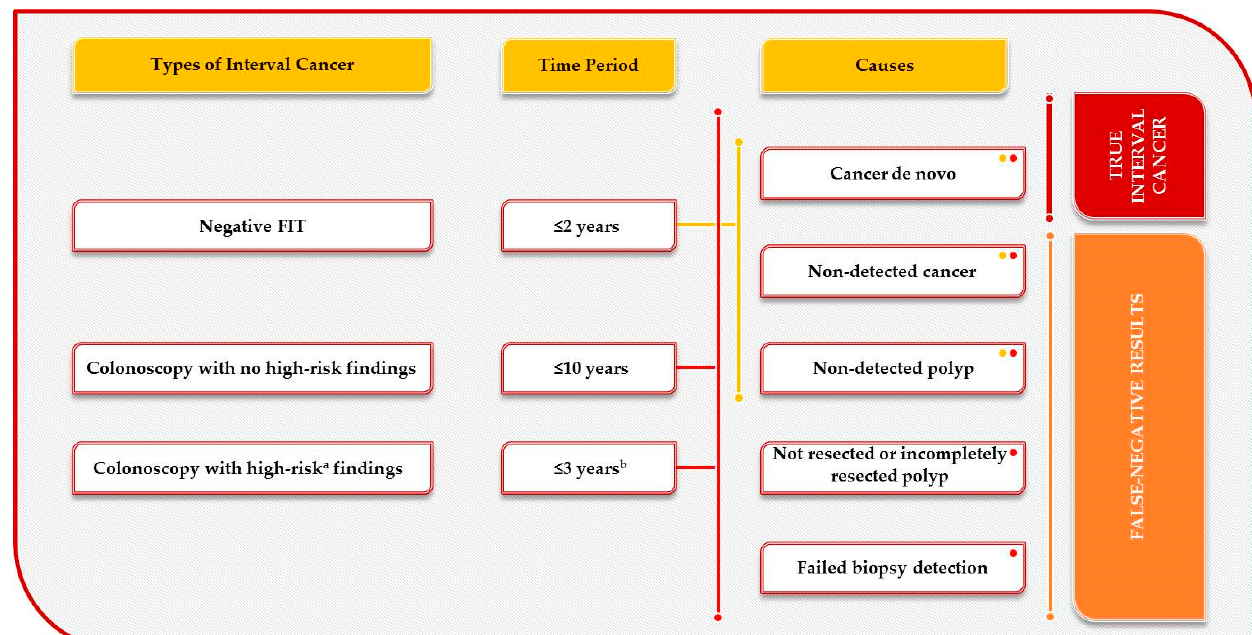
Figure 1. Causes of colorectal interval cancers. FIT interval cancer is caused by de novo cancer (true interval cancer) or non-detected lesions (false-negative FIT results). A post-colonoscopy colorectal cancer is also caused by de novo cancer (true interval cancer) or missed lesions, incompletely resected lesions and failed biopsy (false-negative results). a High-risk findings: individuals with complete removal of at least 1 adenoma ≥ 10 mm or with high-grade dysplasia, or ≥ 5 adenomas, or any serrated polyp ≥ 10 mm or with dysplasia according to current guidelines [5–7]. b Except for the need for a 2- to 6-month early repeat colonoscopy following piecemeal endoscopic resection of polyps ≥ 20 mm.